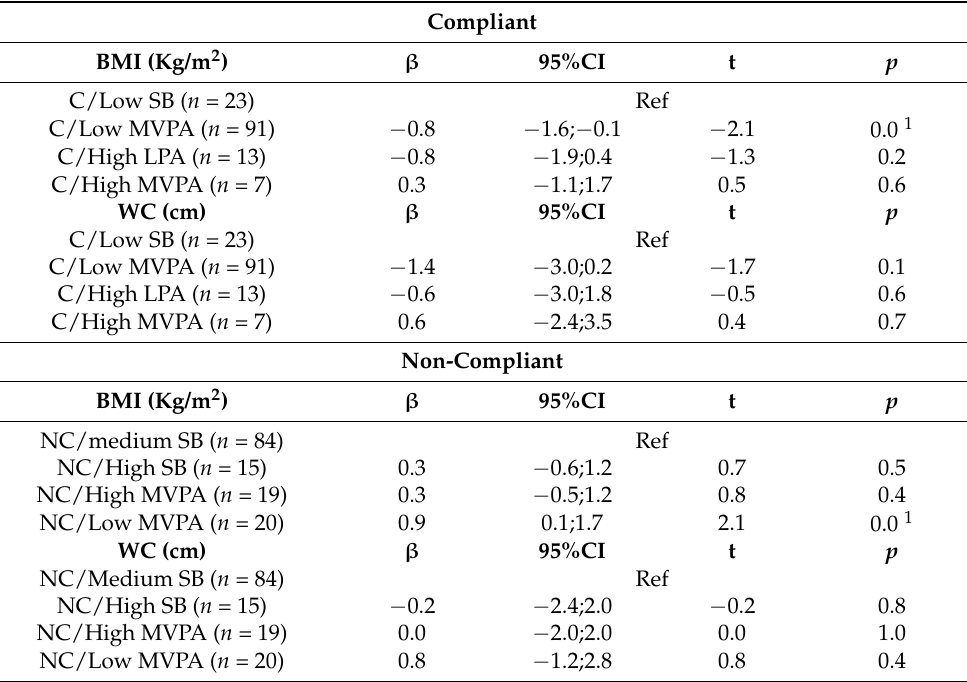
Table 4. Associations between clusters and obesity markers, according to compliance with sleep